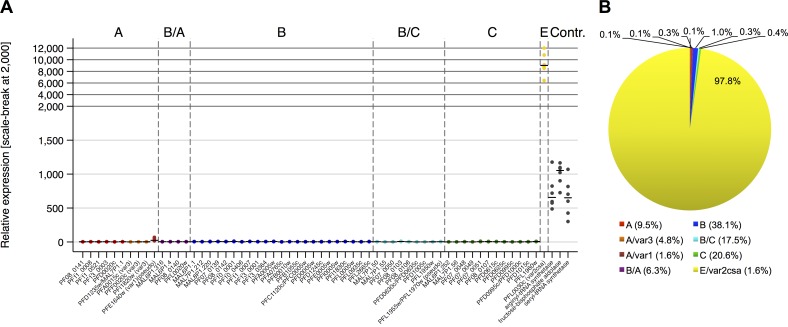

Var transcription profiles of parental parasite lines used for volunteer infection.(A) The gene expression of each var gene and control genes relative to sbp1 expression is shown in dot plots for the pre-mosquito Master Cell Bank (MCB) parasite line. Each point represents values observed per test generation for the MCB samples taken from two independently thawed parasite stocks after 6, 8 and 21 parasite generations, respectively (n = 6). The median expression per var gene is shown, housekeeping genes used as controls, var gene names and groups are indicated. (B) The MCB cell line exclusively expresses the group E var2csa gene as shown by the proportion of var transcripts according to var group affiliation. The genomic proportion of each var gene group is indicated after the color code.